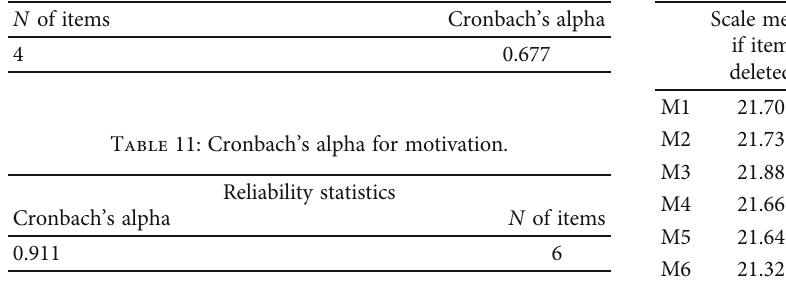
Table 13: Item-total statistics for